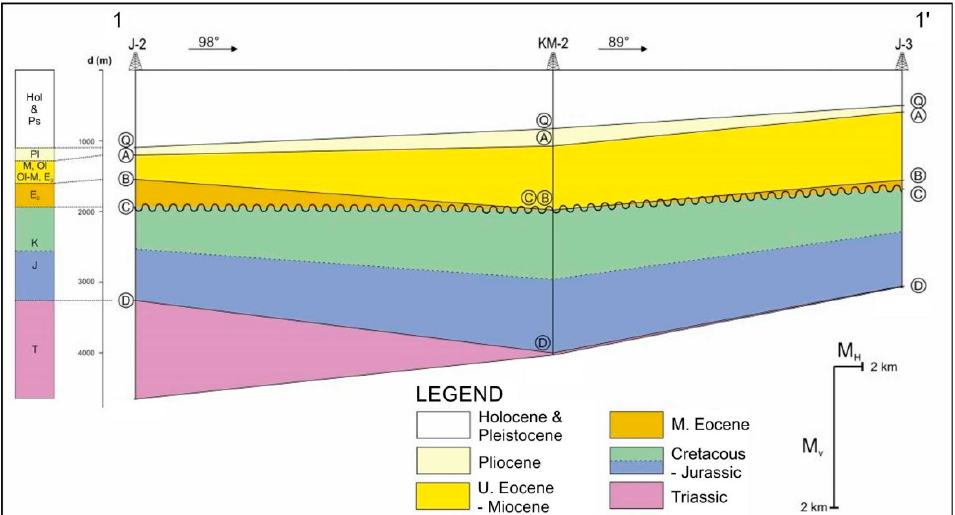
(cid:48) (location in Figures 3 and